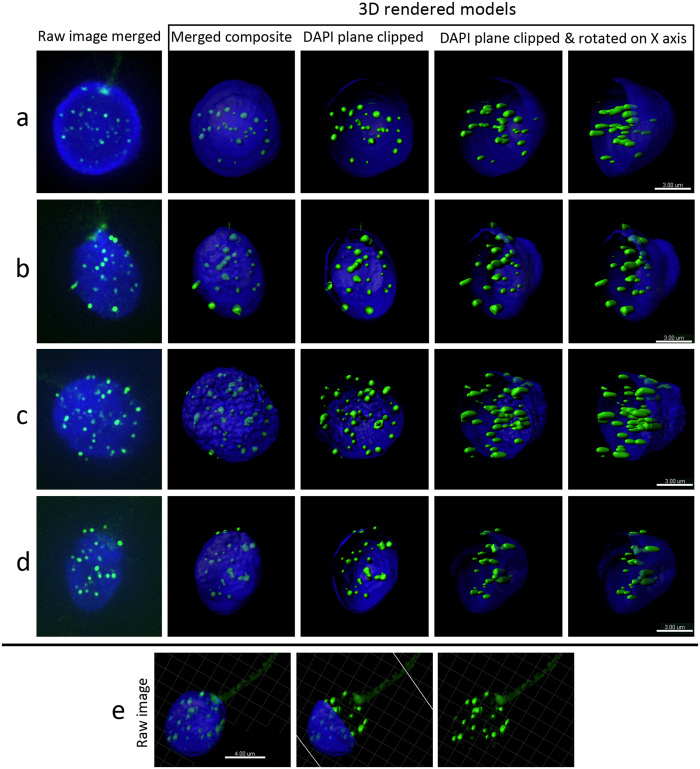
Representative images of 3D telomere organization in sperm nuclei.Panels a–d display the 3D localization of telomeres in four representative sperm cells. Nuclei are stained blue with DAPI, with telomere signals shown in green. Nuclei were captured with a Z step of 0.2 μm, with a minimum of 92 sections per nuclei using wide-field microscopy (Deltavision) and subjected to deconvolution (SoftWoRx). The first image on the left side of panels a–d, shows the raw image following deconvolution. 3D models were rendered with Imaris software (Bitplane, Switzerland, the second image in panels a–d, display the formation of 3D models with rendered telomeres (merged composite). The third image subsequently shows the same models with the DAPI partially removed (DAPI plane clipped) to better observe the 3D radial distribution of telomeres throughout all regions of the nucleus. The fourth and fifth images show the same DAPI clipped models rotated along the X-axis to further depict the
3D radial organization. Scale bar = 3 μm. Panel e displays a single sperm cell following 3D modeling that clearly depicts the sperm tail that is utilized to evaluate the longitudinal organization of telomeres with full DAPI, partially clipped DAPI and no DAPI. This clearly displays that sperm telomeres are longitudinally localized throughout the sperm nucleus from the sperm head to the tail). Scale bar = 4 μm.